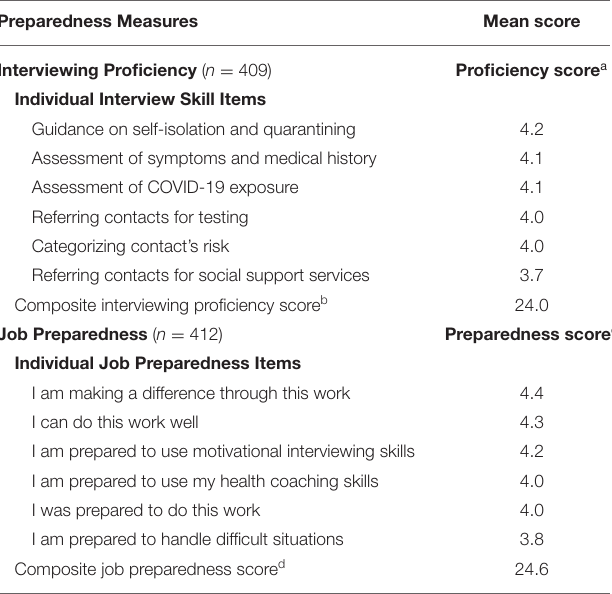
TABLE 2 | Self-perceived interviewing proficiency ( n = 409) and job preparedness ( n =